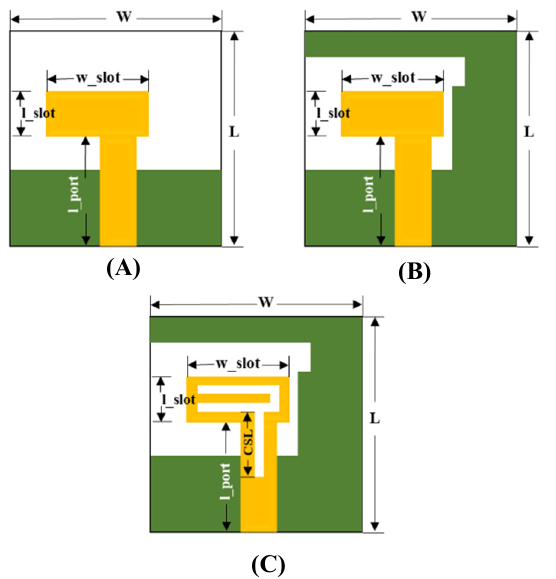
Figure 2. Design-evolution process of the single-element antenna. ( A ) Step–1, ( B ) Step–2, ( C ) Step–